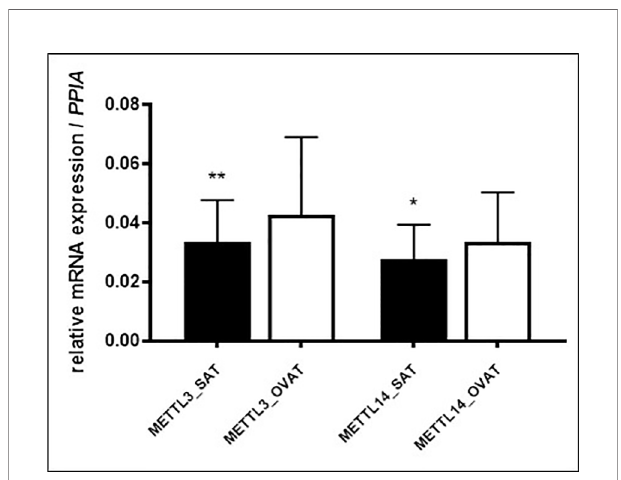
FIGURE 3 | m6A writers showing signi fi cant differential gene expression in SAT vs. OVAT (RT-qPCR validation). Differences in gene expression between SAT and OVAT measured by RT-qPCR. Relative expression values using PPIA as housekeeping gene. Data are presented as mean ± SD. P -values were calculated using Wilcoxon signed rank test in n=46 individuals. (*P < 0.05; **P < 0.01). OVAT, omental visceral adipose tissue; SAT, subcutaneous adipose tissue.